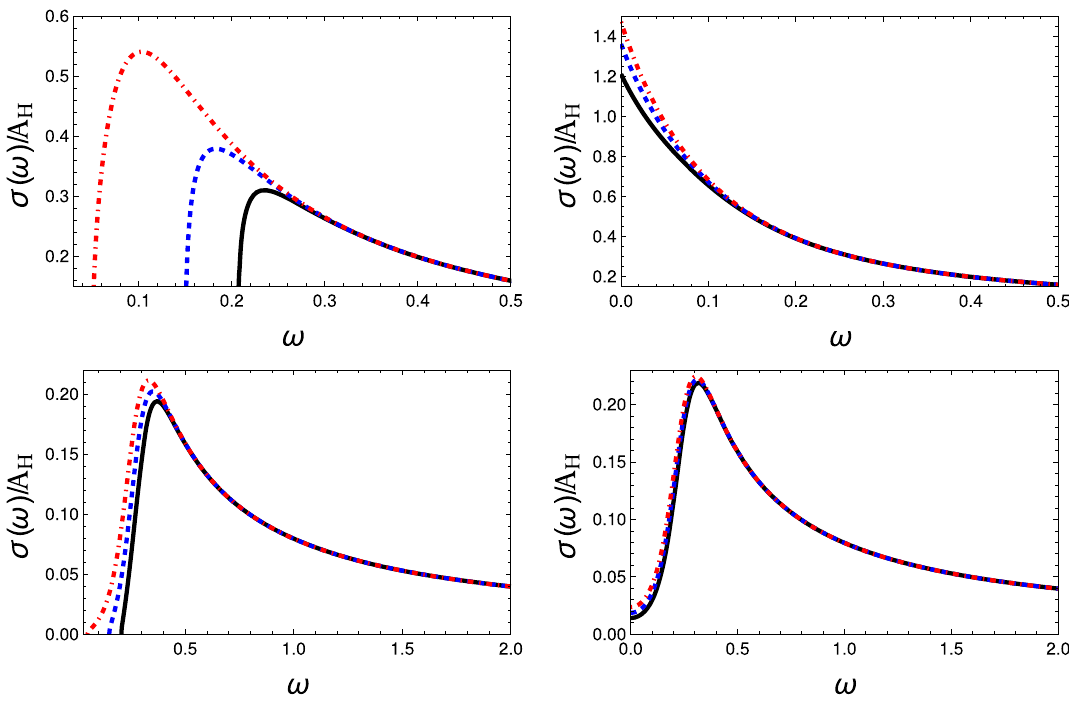
line), and ξ = 0 . 12 (dotted-dashed red line). Right panel: reflection coefficient versus frequency for ξ = 0 . 15 (solid black line), ξ = 0 . 16 (dashed blue line) and, ξ = 0 . 17 (dotted-dashed red line). In both fig- ures we fix m = 1, r H = 2 and η = 0 . 25